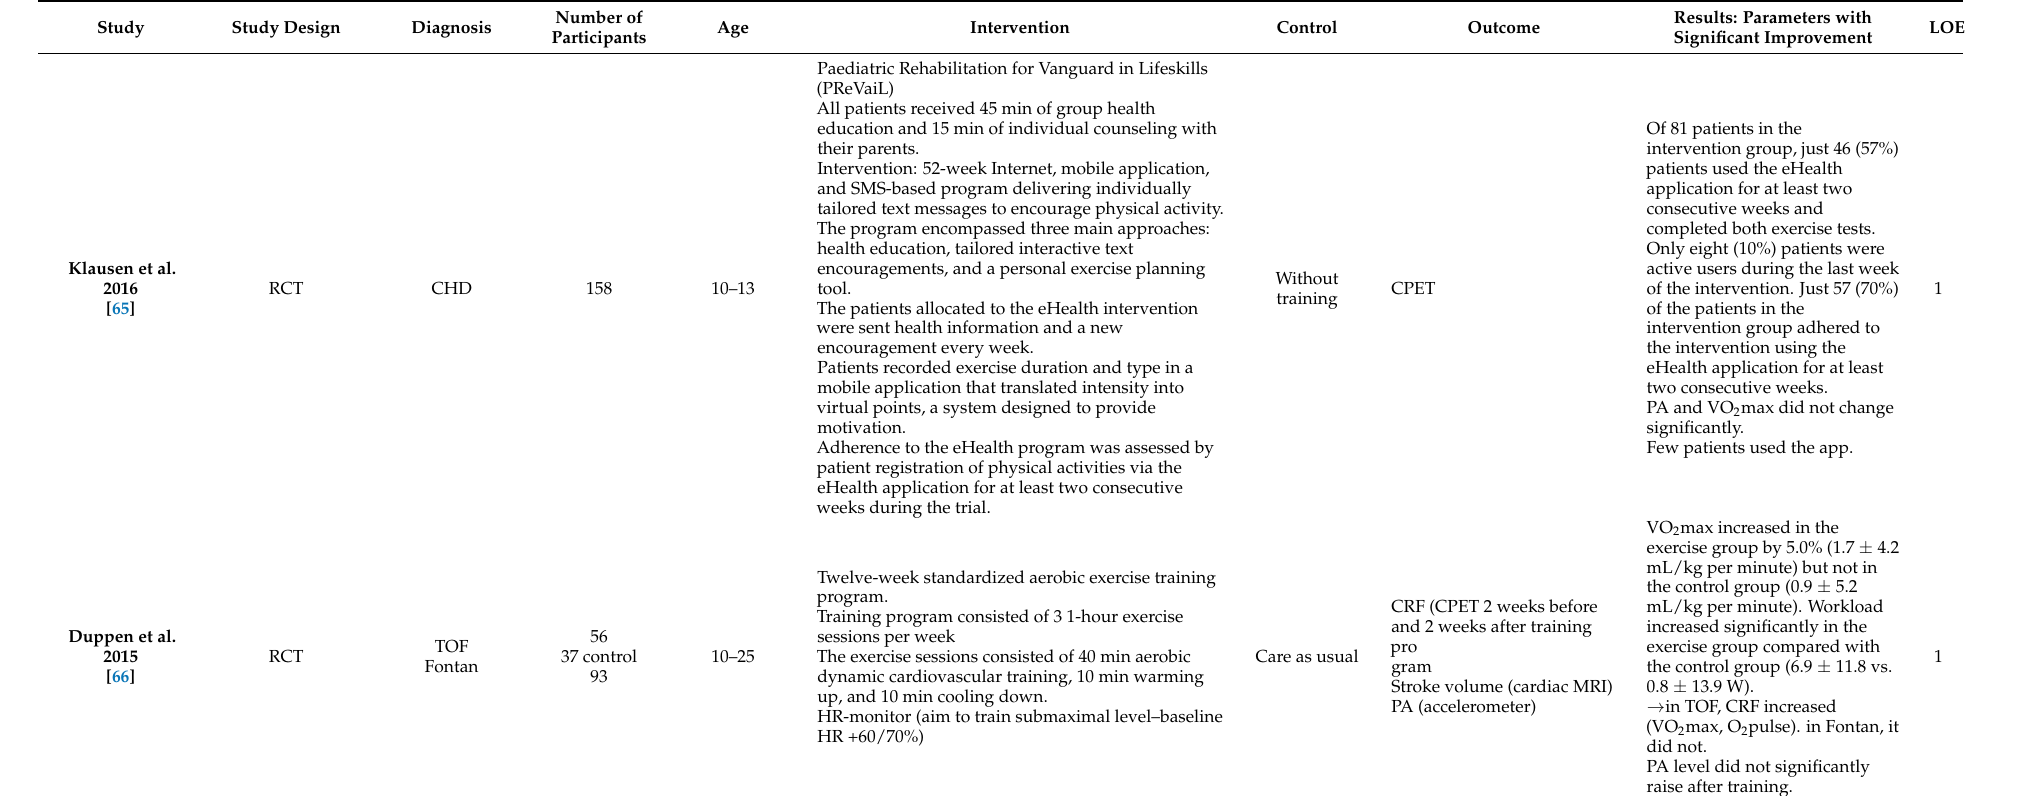
Twelve-week standardized aerobic exercise training